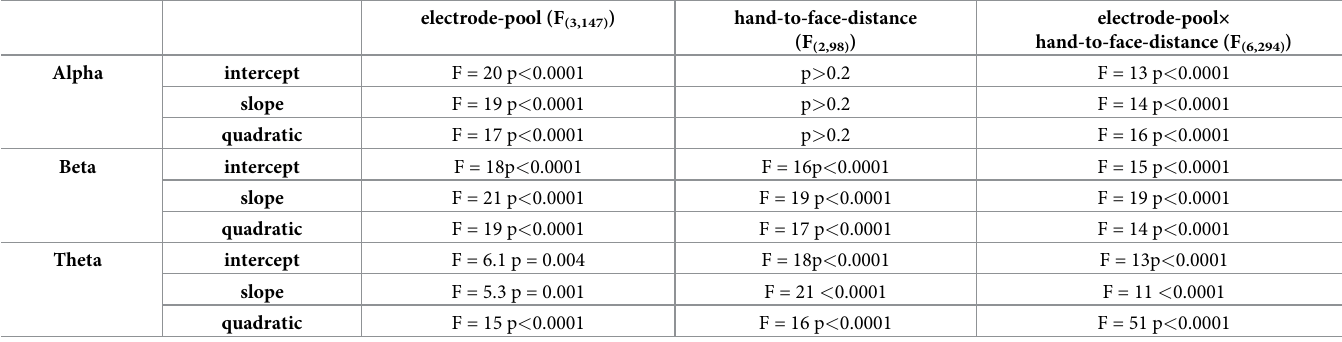
Table 1. Significant ANOVA